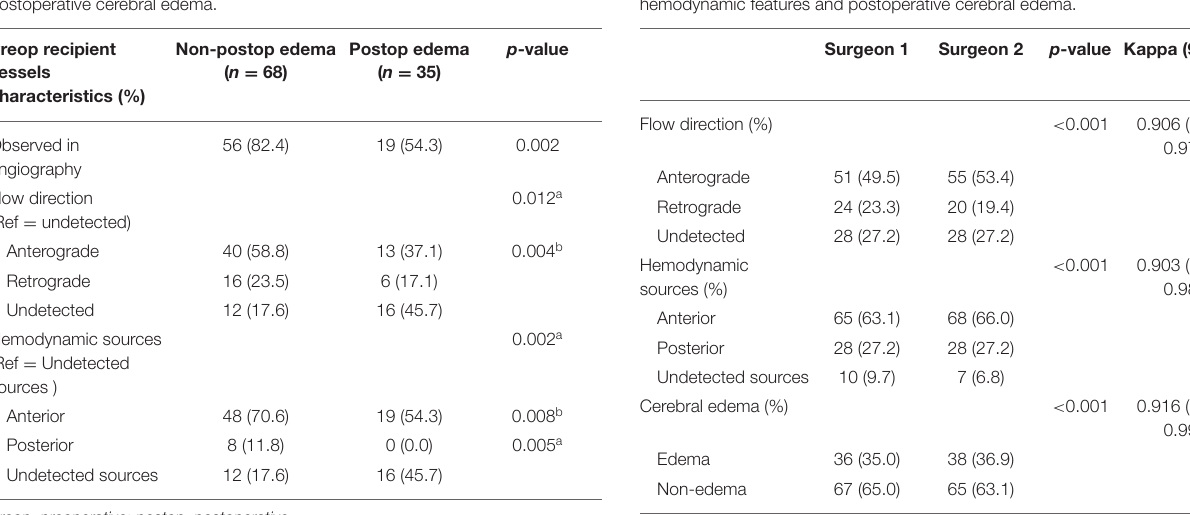
TABLE 4 | The interrater reliability involved in the estimation of recipient hemodynamic features and postoperative cerebral